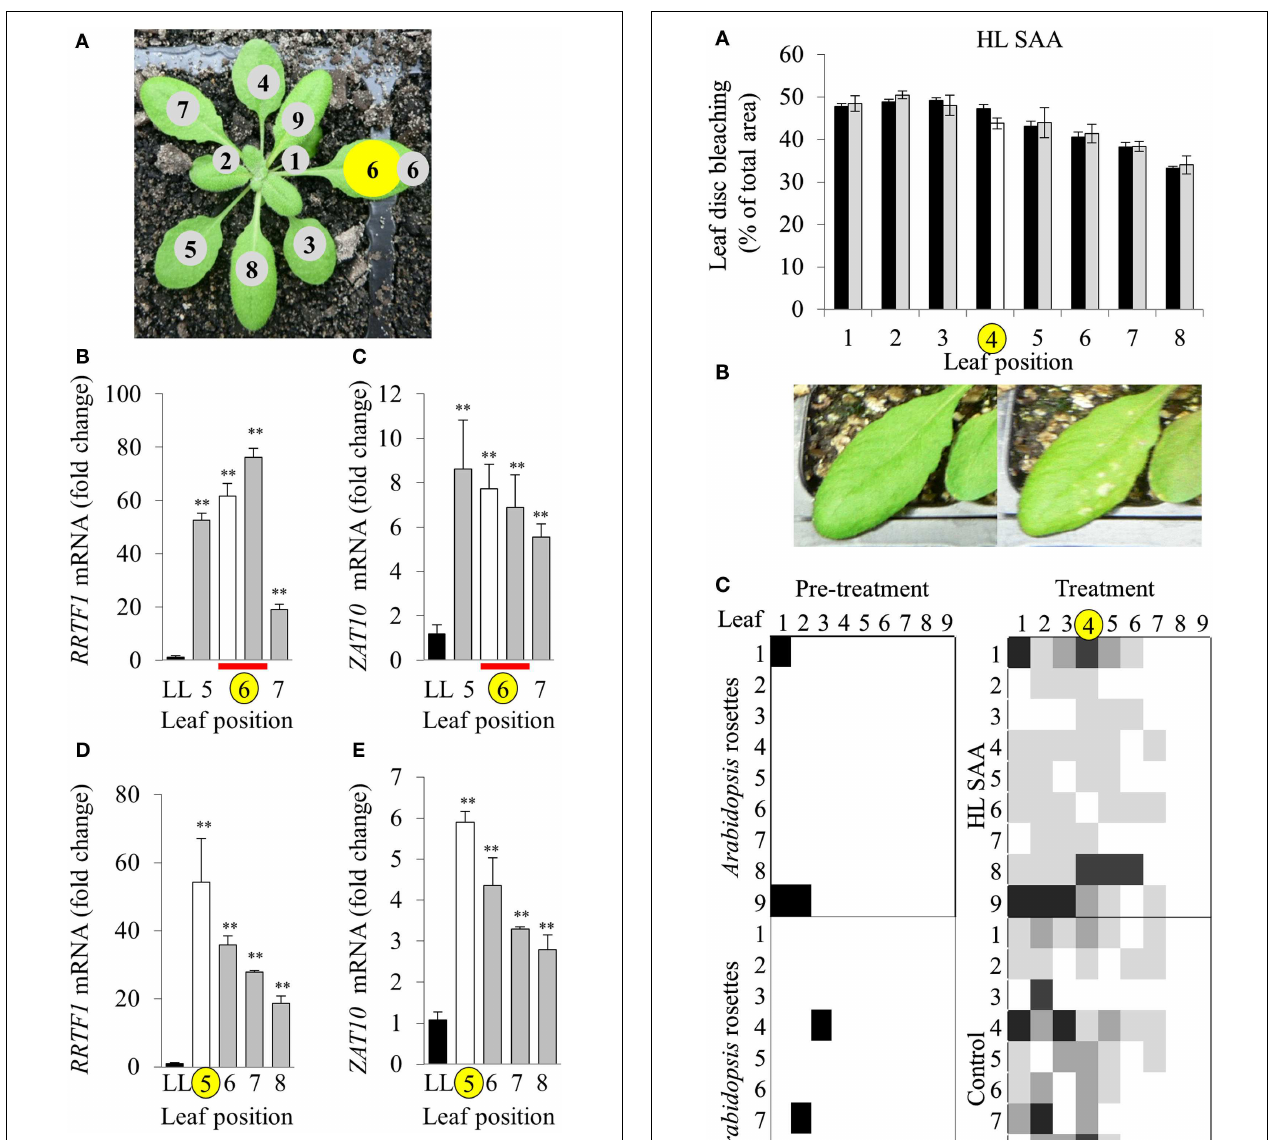
FIGURE 5 | Leaf position-dependent analysis of RRTF1 and ZAT10 transcript abundance during HL SAA. (A) Representative image of leaf positions on the Arabidopsis rosette, where leaf position 6 is HL-treated (yellow). (B,C) HL and distal tissue sampled from leaf 6, distal from leaf positions 5 and 7, where LL control (black), HL (white), and distal (grey) leaves, HL and distal sampled from same leaf (red bar), HL-treated (yellow circle). (D,E) HL-treated leaf position 5, distal leaves 6, 7, and 8. * p < 0.005, ** p < 0.001, n.s., not significant, error bars indicate standard error. n = 6. FIGURE 6 | Leaf position-dependent oxidative stress tolerance during